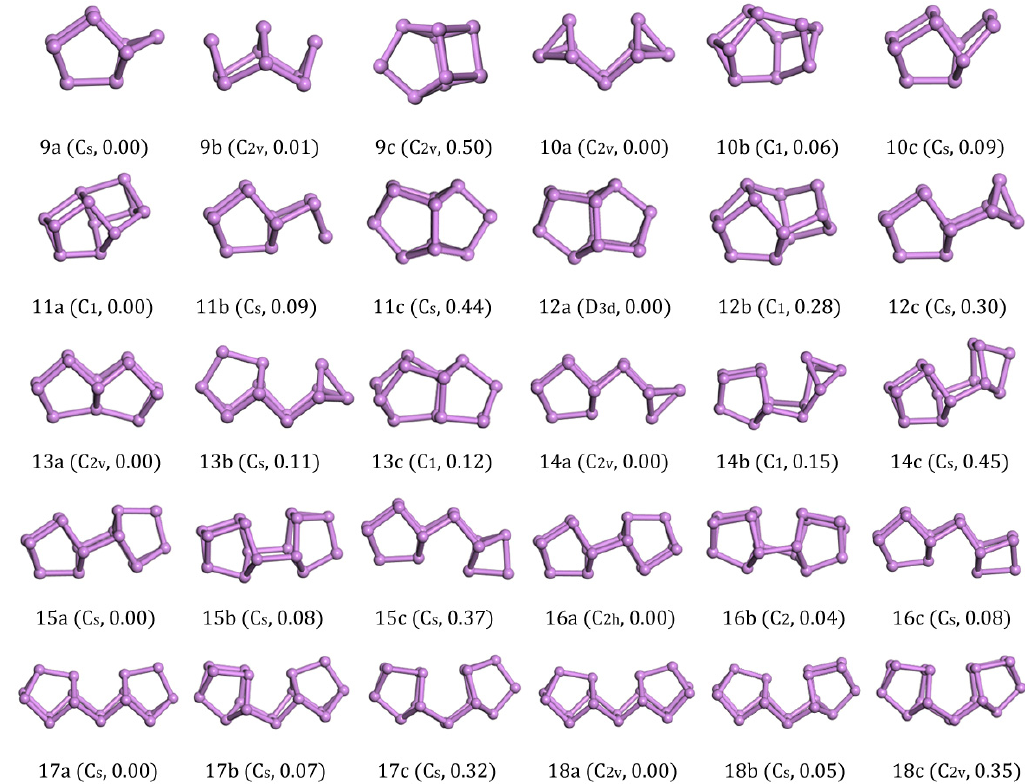
Figure 2. Lowest-energy and isomorphic structures for As n ( n = 9–18) clusters. The relative total energies are in eV.